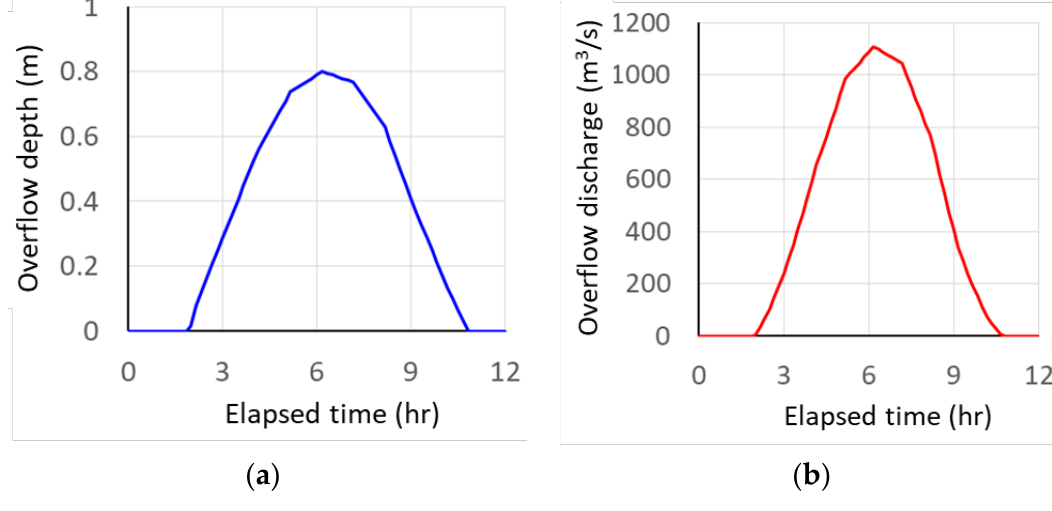
Figure 14. ( a ) Depth and ( b ) discharge for overflow dike.